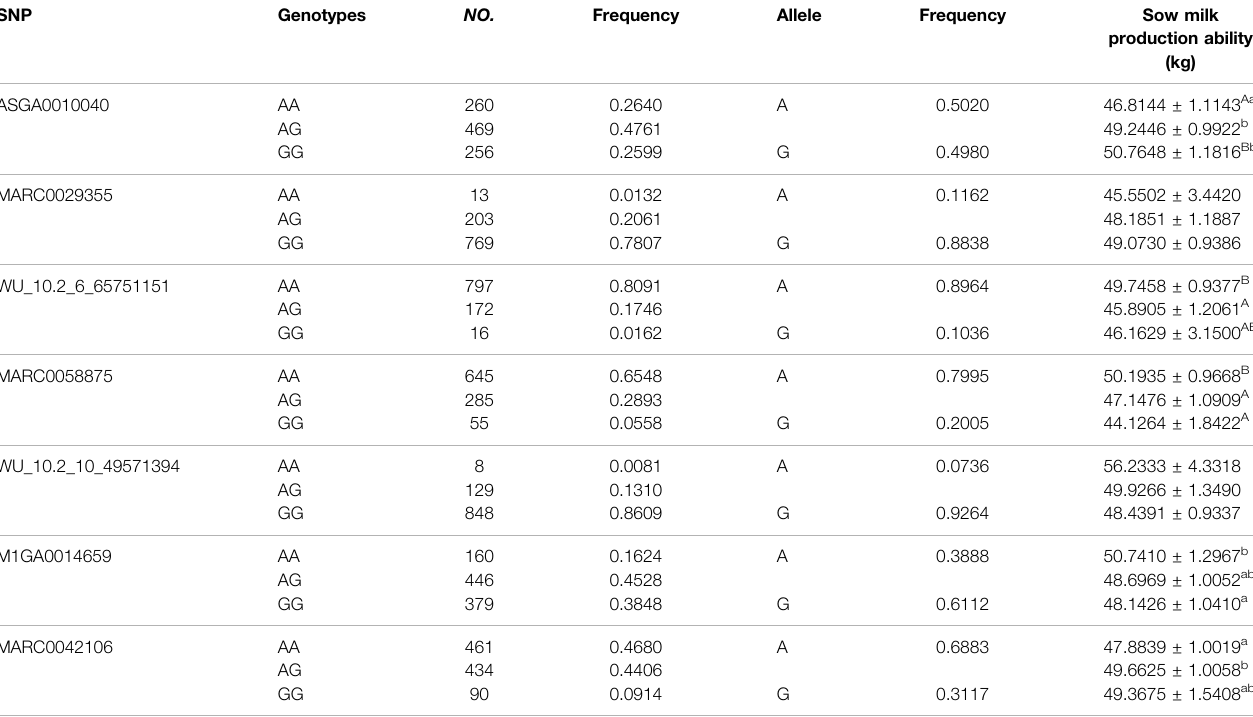
TABLE 2 | Least square mean ( ± SE) of sow litter weight gain (LWG) by the genotype of seven signi fi cant SNPs. SNP Genotypes NO. Frequency Allele